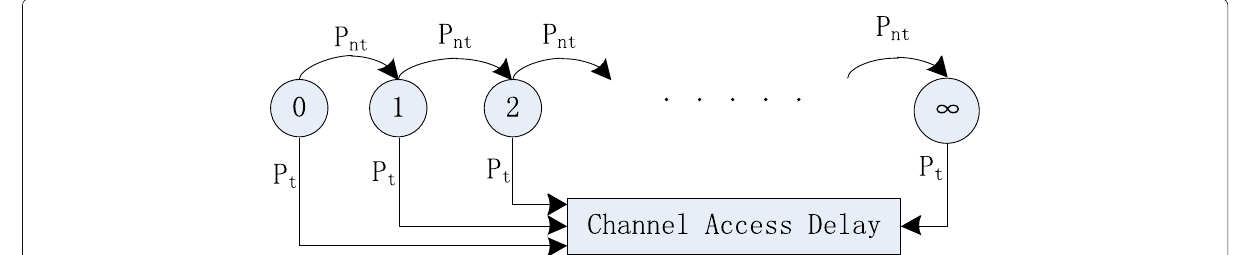
Fig. 6 States of data packets waiting for channel access. State diagram for channel access delay analysis